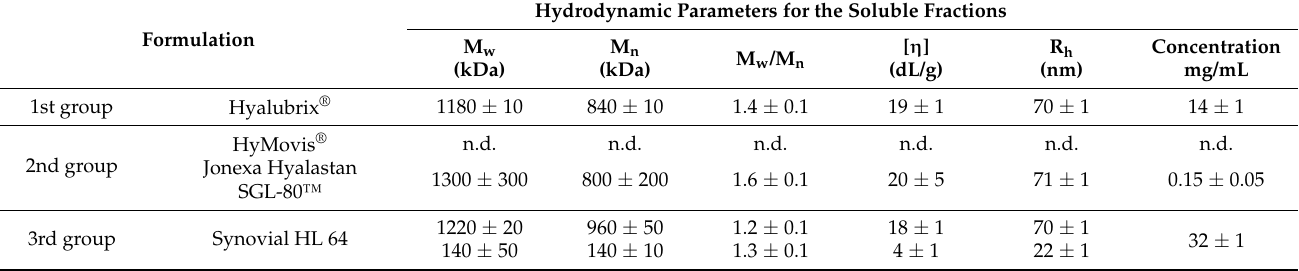
Table 3. Results of the SEC-TDA characterization. Weight average molar mass (M w ), numeric average molar mass (M n ), polydispersity index (M w /M n ), intrinsic viscosity ([ η ]), and hydrodynamic radius (R h ) for the water-soluble HA in the tested formulations. The HA concentration, as derived from the analyses, is also indicated. # for hybrid complexes, chromatographic resolution is not complete, which is as expected; thus, the derived parameters can be considered as “apparent” even if they resemble the original HA population used to obtain the complexes through thermal